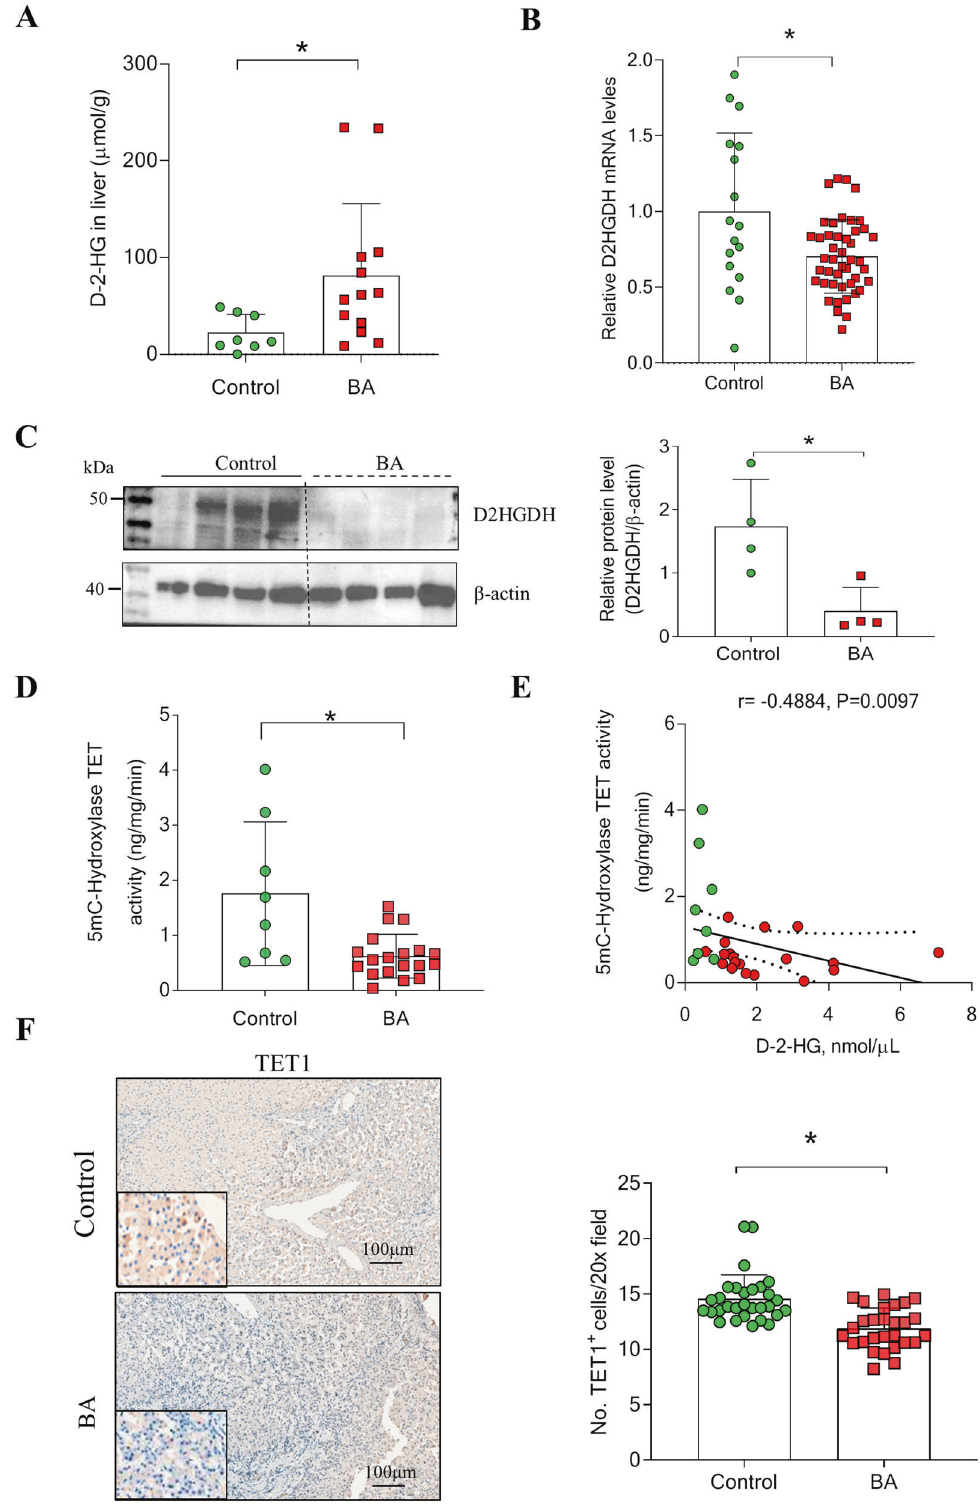
Fig. 2 Accumulation of D-2-HG was correlated with TET activity in BA patients. A The D-2-HG expression was detected in the livers of BA ( n = 13) and controls ( n = 8). B The relative expression of D2HGDH mRNA in the livers of BA ( n = 45) and controls ( n = 17). C Representative images of western blotting (WB) for D2HGDH. Quanti fi cation of D2HGDH against β -actin. D 5mC-Hydroxylase TET activity was determined in the livers of BA patients ( n = 19) and controls ( n = 8). E Correlation analysis of plasma D-2-HG levels with 5mC-Hydroxylase TET activity in liver tissues. F Representative Immunohistochemistry (IHC) images of TET1 in livers of BA patients ( n = 6) and controls ( n = 6). The quanti fi cation of TET1 positive cells. Statistical signi fi cance: * p < 0.05.